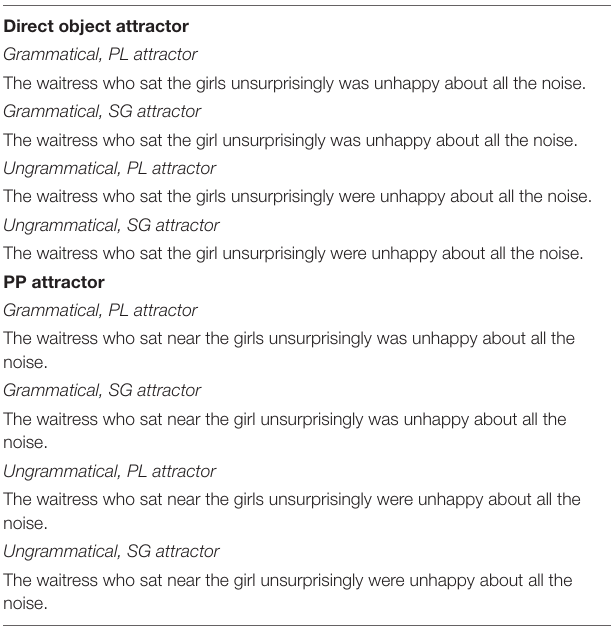
TABLE 1 | Sample set of items for Experiment